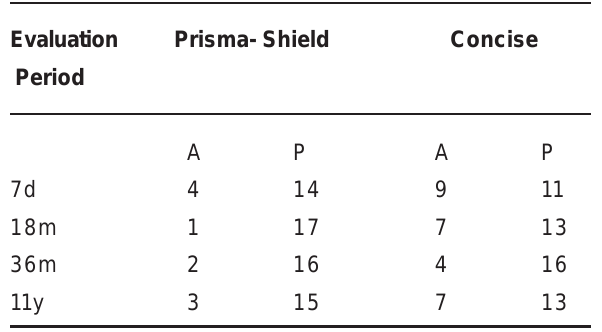
TABLE 1- Concise (S1) and Prisma-Shield (S2) sealants, according to the presence or absence of bubbles after the occlusal sealing periods